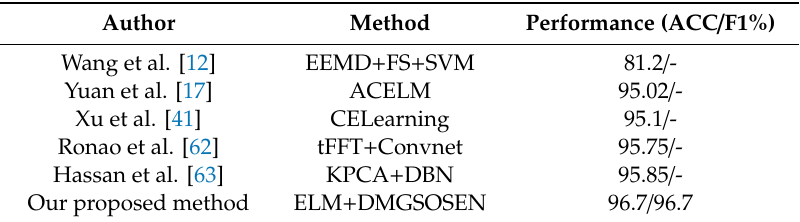
Table 18. Comparison with some previous studies in